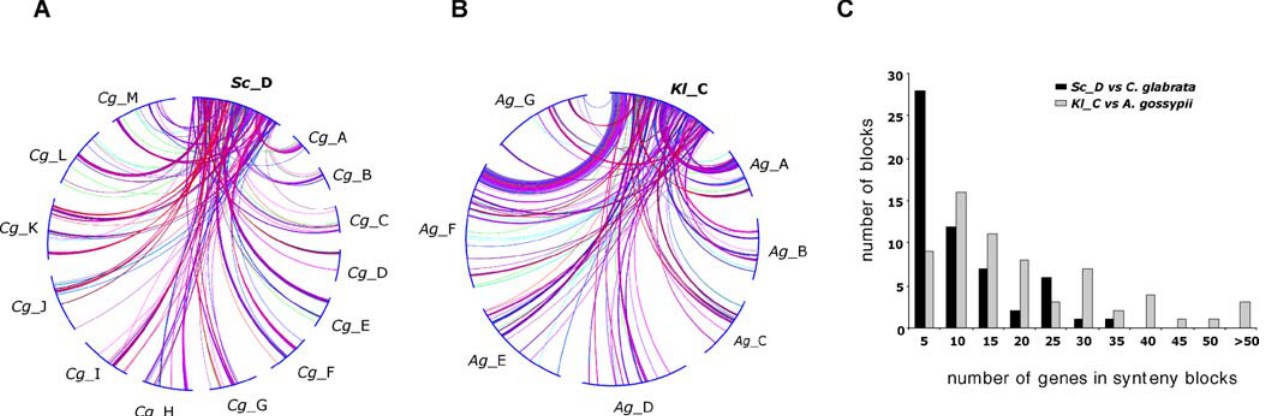
Figure 4. Chromosomal Map Reorganization between Related Species The circular representation is adapted from [25]. (A) Chromosome D from S. cerevisiae ( Sc _D) is represented in a circle with the 13 chromosomes from C. glabrata ( Cg _A to M). Each line joins two orthologs and the color of the lines represents the percentage of similarity between orthologous gene products (green (cid:2) 50% (cid:2) cyan (cid:2) 60% (cid:2) blue (cid:2) 70% (cid:2) magenta (cid:2) 80% (cid:2) dark magenta (cid:2) 90% (cid:2) red). (B) Same representation between chromosome C of K. lactis ( Kl _C) and the seven chromosomes from A. gossypii ( Ag _A to G). The diagram shows large uninterrupted regions of conserved synteny between Kl_ C and Ag _F or Ag _A, while no such conservation is visible between Sc _D and any of the C. glabrata chromosomes. (C) Distribution of the length of the corresponding syntenic blocks between Sc _D and C. glabrata (black) and Kl_ C and A. gossypii (gray). DOI: